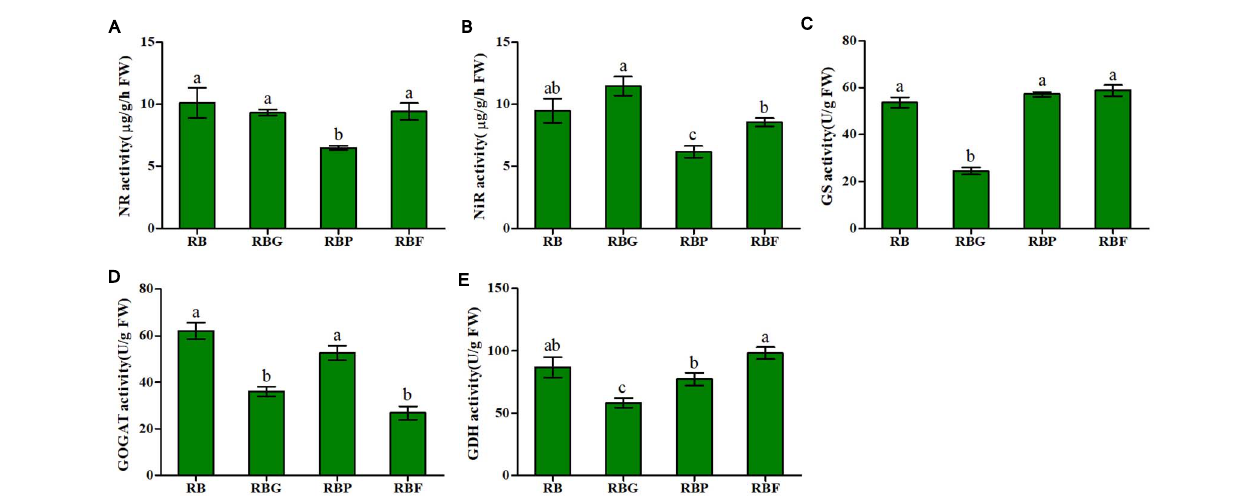
FIGURE 4 | Effects of spectra on enzyme activity of nitrogen metabolism in lettuce. (A) NR activity, (B) NiR activity, (C) GS activity, (D) GOGAT activity, (E) GDH activity. RB, 75% red + 25% blue LED; RBG, 60% red + 20% blue + 20% green LED; RBP, 60% red + 20% blue + 20% purple LED; RBF, 60% red + 20% blue + 20% infrared LED. The letters represent the significant difference of different treatments ( p <